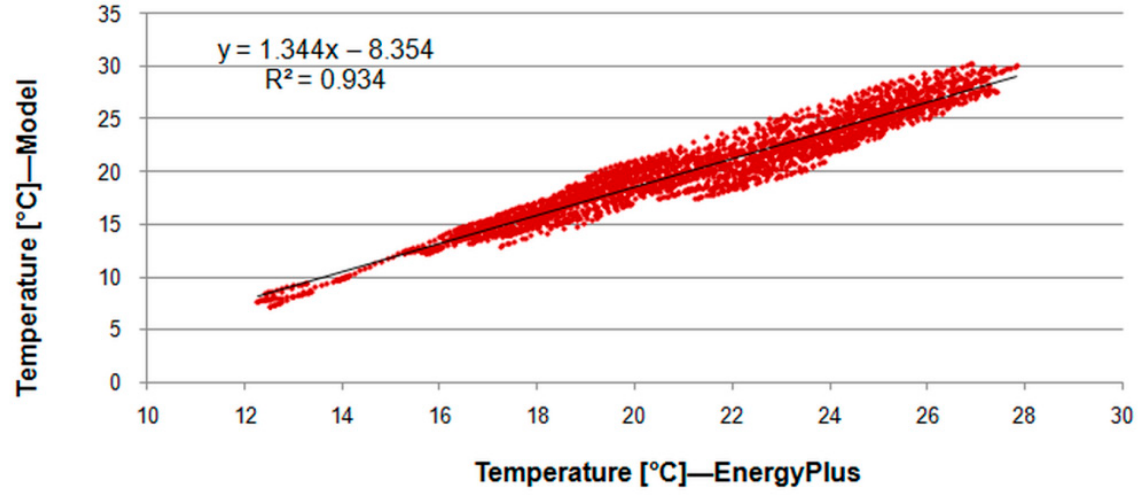
Figure 11. Hourly operative temperature from EnergyPlus and presented model.